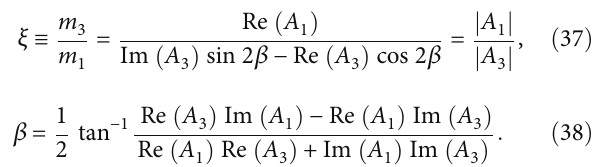
Table 2: Current neutrino oscillation parameters from global fi ts [89] with Δ m 2 Neutrino parameter